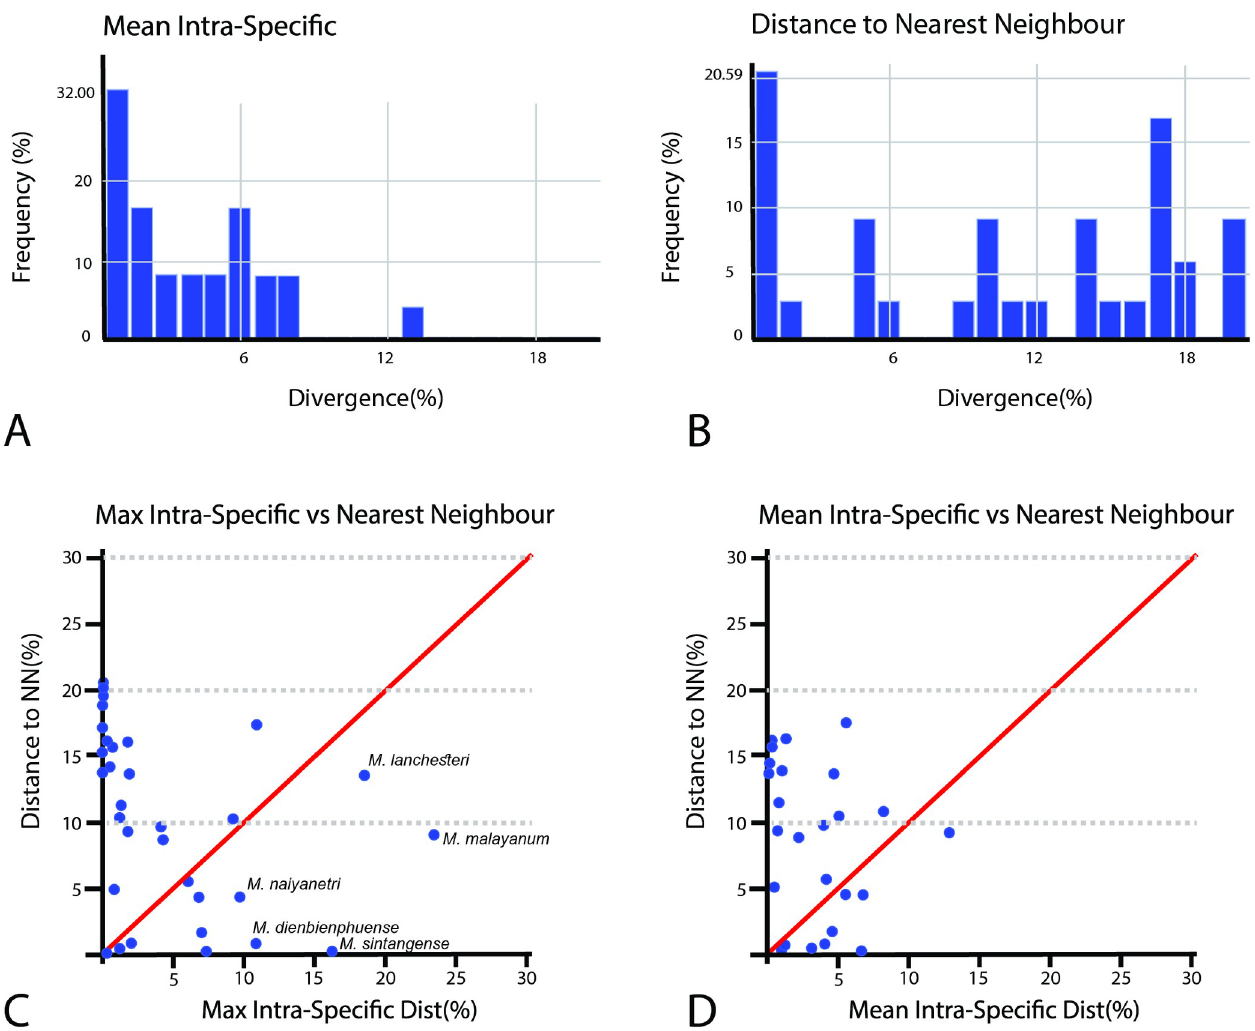
Fig 6. Results of genetic distance obtained from BOLD under K2-parameter model; A. Mean intra sequence divergence B. Distance to nearest-neighbor species based on sequence divergence C. Comparison of maximum intraspecific variation and distance to nearest-neighbor species D. Comparison of mean intraspecific variation and distance to nearest-neighbor